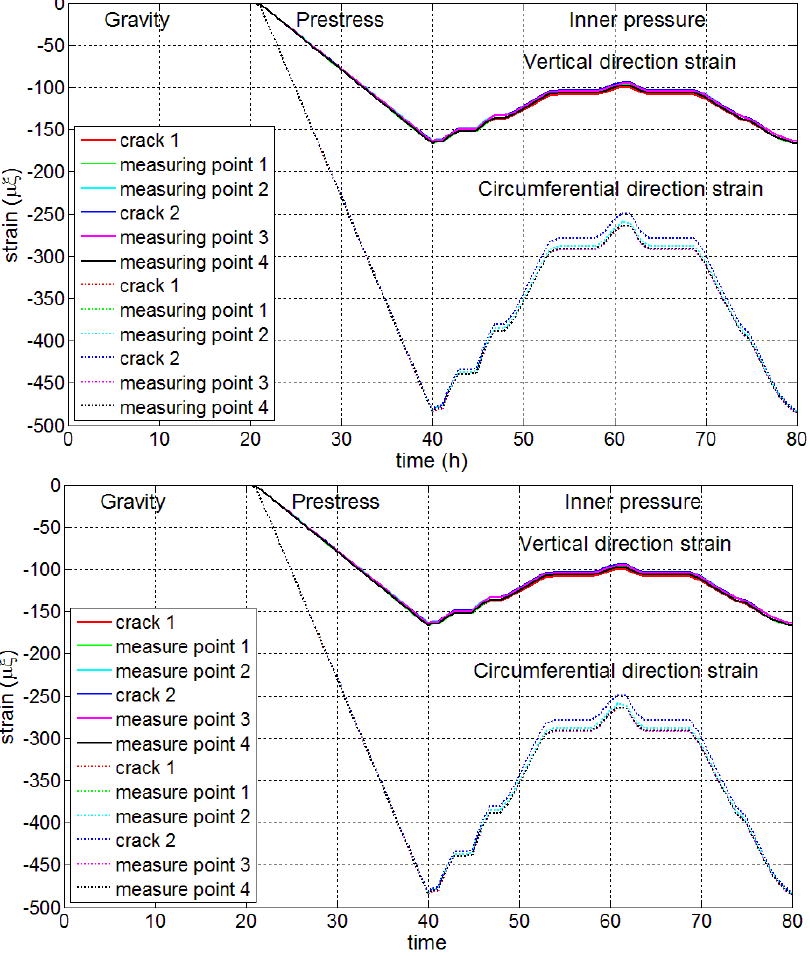
Figure 10. The results of vertical direction strain and circumferential direction strain.